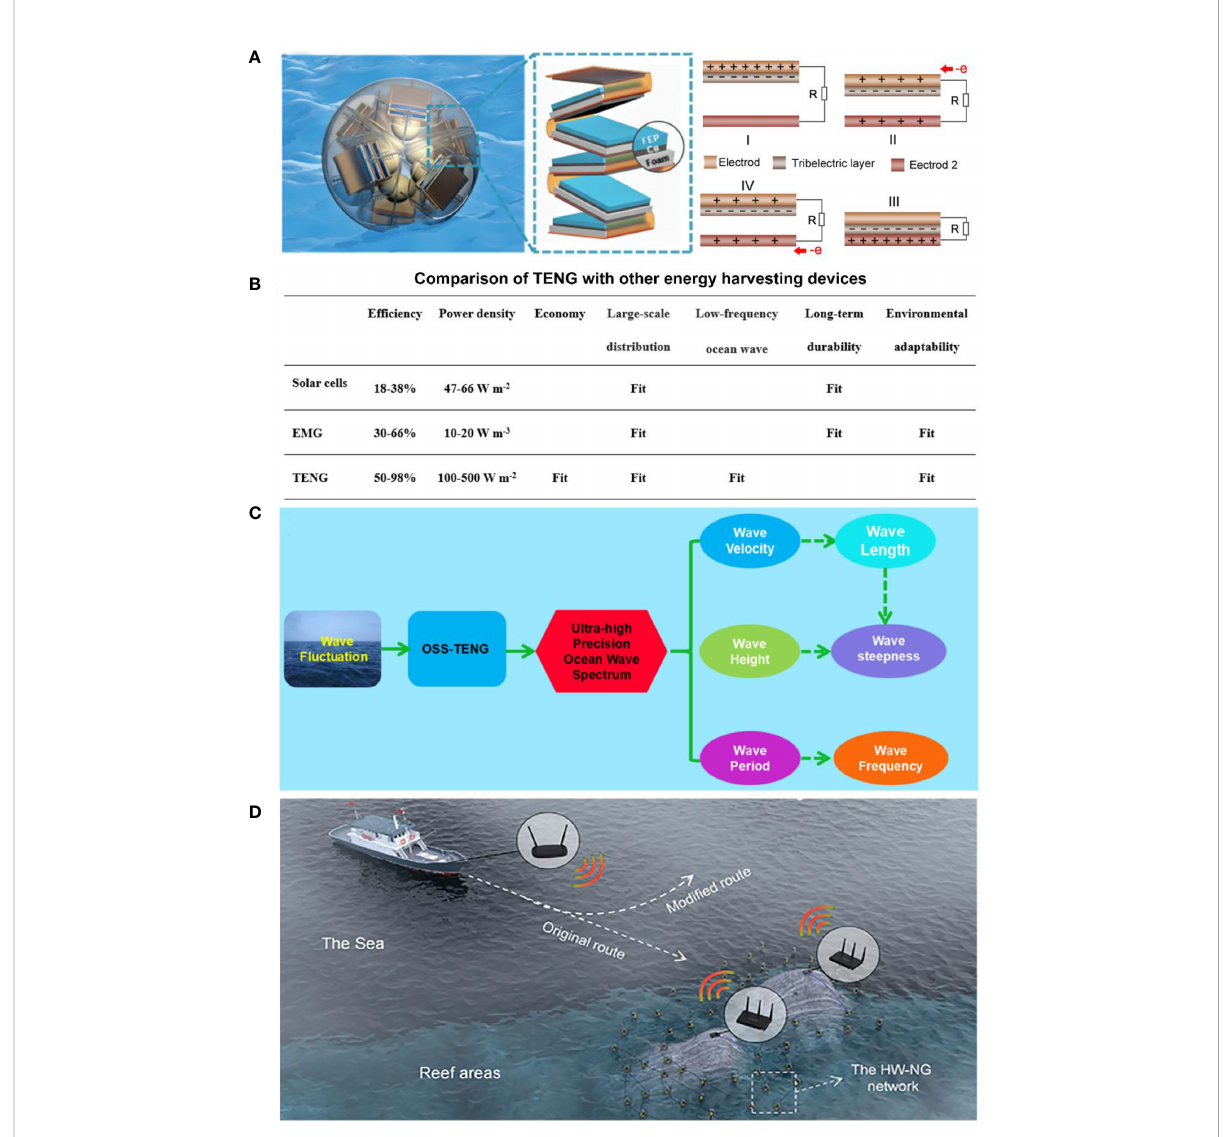
FIGURE 1 (A) The working mechanism of TENG (Hao et al., 2022). (B) Comparison of TENG with other energy harvesters (Hu et al., 2022) (Miller and Keith, 2018) (Wang et al., 2017) (Green, 2020). (C) Flowchart of TOSS acquiring data on ocean-wave spectrum and multi parameters (Zhang et